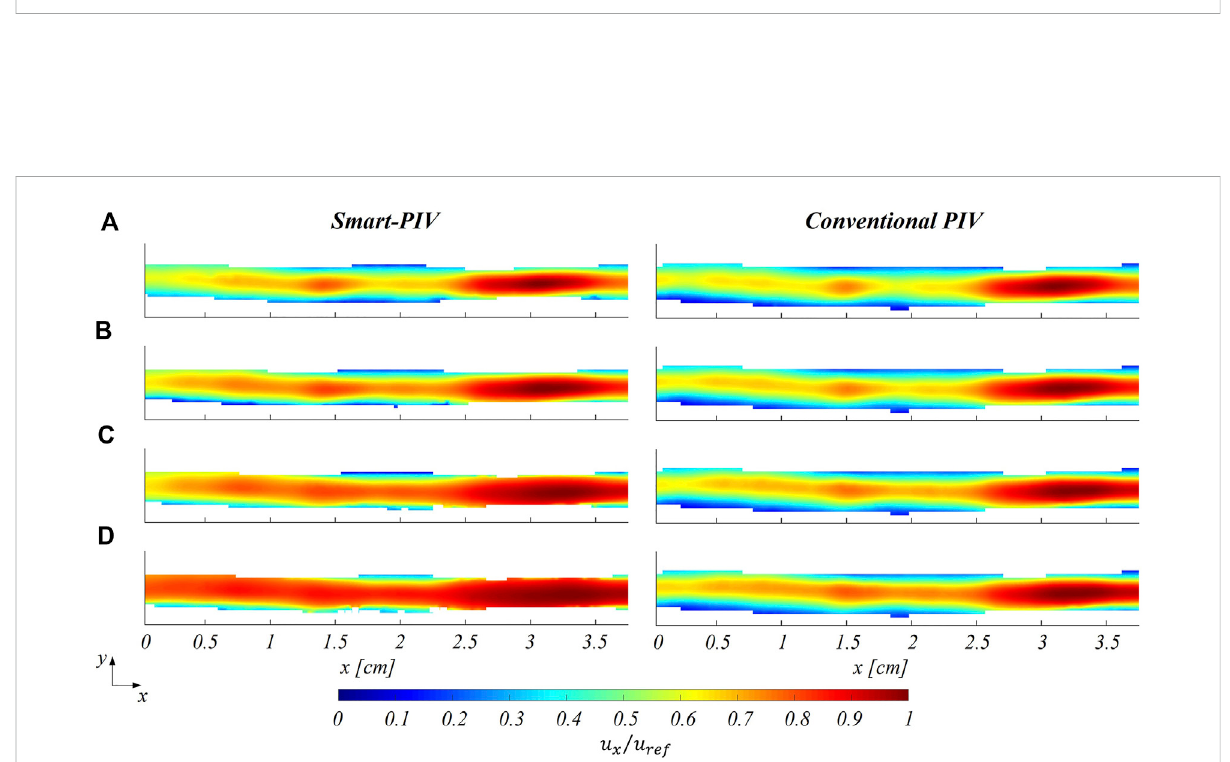
FIGURE 7 Normalized mean streamwise velocity contours for smart (left panel) and conventional (right panel) PIV at four different fl ow regimes: (A) Re inflow = 43, (B) Re inflow = 85, (C) Re inflow = 171, (D) Re inflow = 213 for the healthy LAD phantom. The mean stream-wise velocity ( u x ) is normalized to the maximum streamwise velocity ( u ref